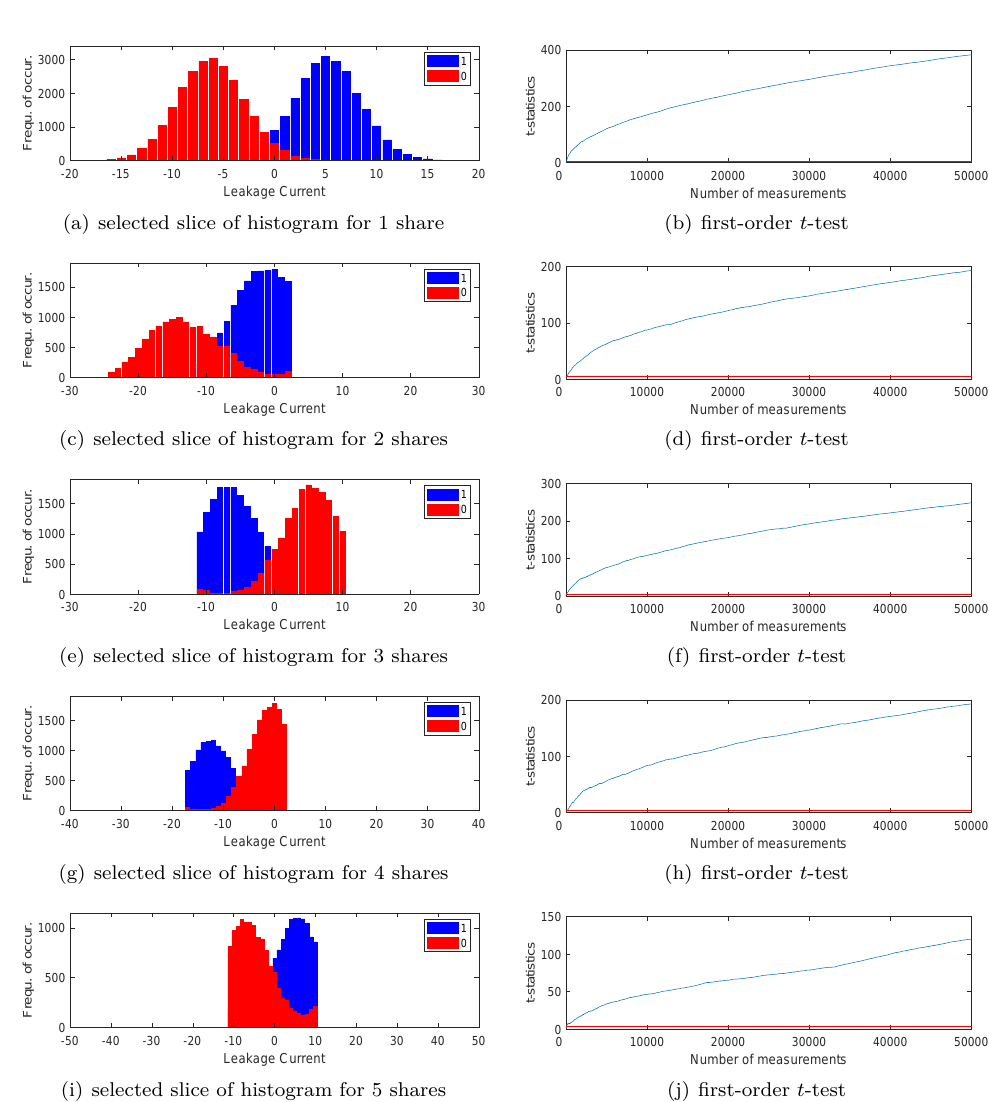
Figure 10: Histogram slices and t -test results for 50,000 static power measurements of 1-bit of information shared among 1, 2, ..., 5 (top to bottom) high-fanout register bits in 65 nm CMOS technology, recorded at 90 ◦ C and 1 . 6